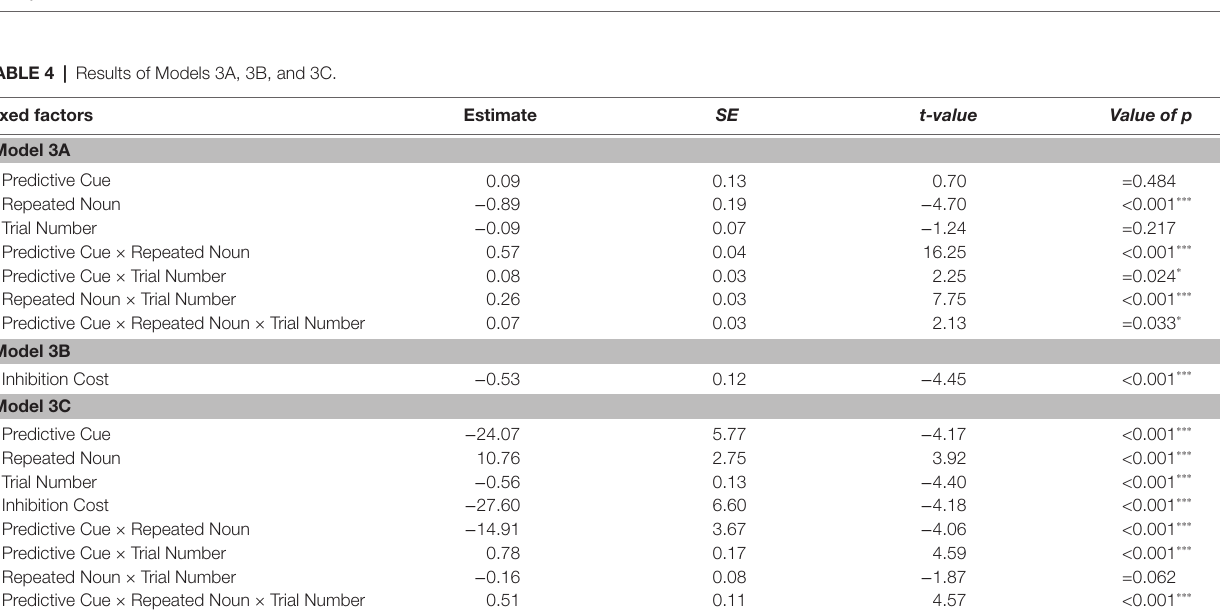
FIGURE 5 | Proportion of looks over time to the target object across conditions in German (L1) after the training phase. The shaded area corresponds to the analysis window.